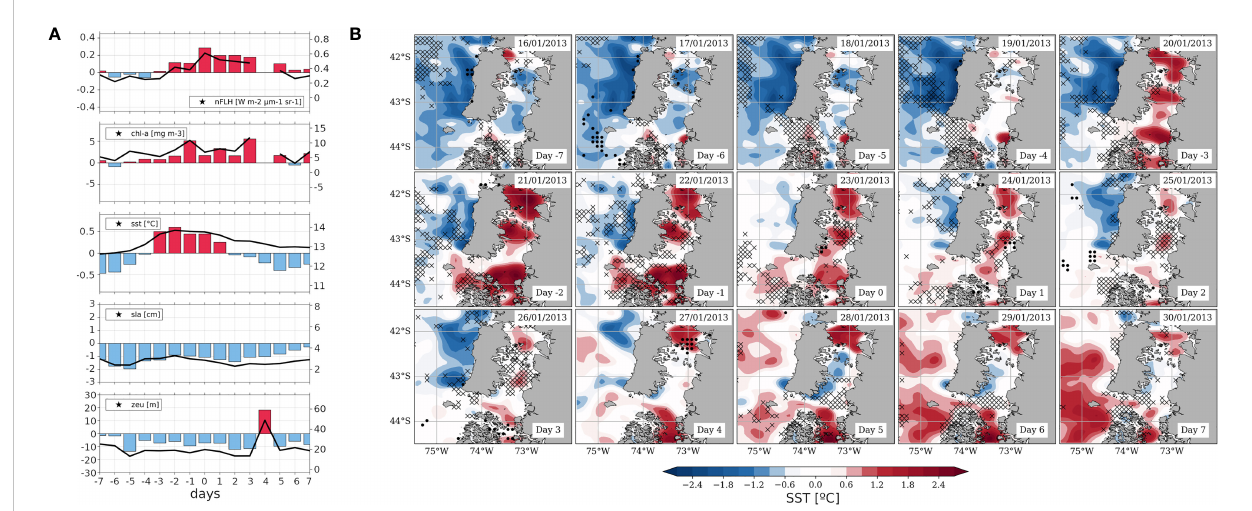
FIGURE 11 As Figure 5, but referred to the case study around the HBE of January 23, 2013 (day 0). (A) Time series calculated as fi eld averages within the S-ISC subregion (42.5°-43.5° S; see Figures 1A) for a sequence of days centred on the HBE onset, i.e., on day 0, spanning from day -7 to day +7. Variables correspond to nFLH [W m -2 m m -1 sr -1 ], CHLA [mg m -3 ], SST [°C], SLA [cm] and ZEU [m]. The right-hand y-axis of each panel shows the absolute values on solid black lines centred around the mean DJF value (central horizontalline), while the left y-axis shows the positive (negative) SY-IS anomalies on red (blue) bars centred around 0. (B) Maps centred on day 0, spanning from day -7 to day +7, showing SST ’ ( fi lledcontours, see colour scale), ZEU' [for graphical convenience with respect to the SST ’ pattern, crosses (dots) depict shoaling (deepening) anomalies below -14m (above